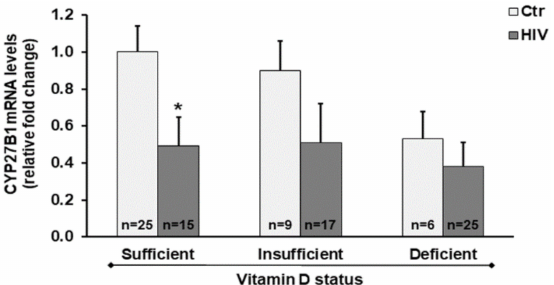
Figure 2. CYP27B1 expression in peripheral blood mononuclear cells (PBMC) from HIV + and healthy subjects. mRNA transcript levels were evaluated by real-time PCR. The results are expressed as mean ± SEM. * p < 0.05 significant di ff erence in comparison to healthy subjects with su ffi cient 25(OH)D 3